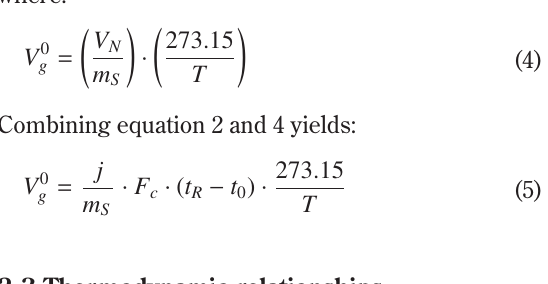
Fig. 2 The increase in retention time for increasing n- alkane chain lengths at infinite dilution concen-